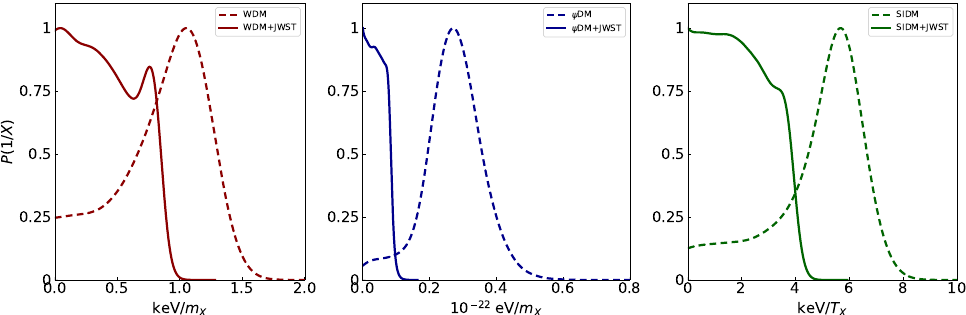
Figure 8. Forecasts of marginalized posteriors on the WDM mass (left panel), ψ DM mass (middle panel), and SIDM kinetic temperature at decoupling (right panel) based on prospective data at z (cid:38) 10 from JWST (solid lines; see text for details). For reference, the dashed lines illustrate the current constraints from Figures 4–6. The marginalized distributions are in arbitrary units (normalized to 1 at their maximum